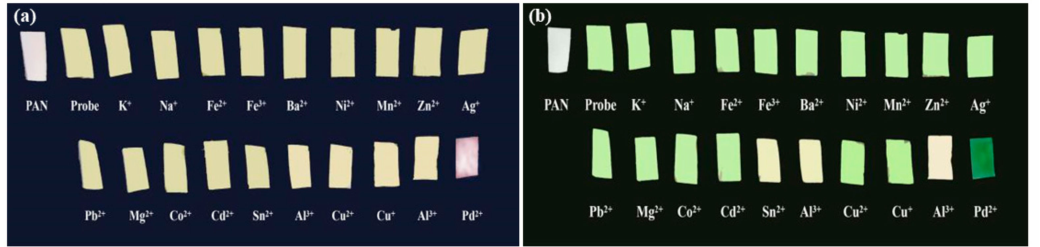
Figure 9. Photographs of RCya–PAN composite nanofibers upon exposure to the aqueous solutions of various metal ions: ( a ) under ambient light; ( b ) under a hand-held UV lamp at 365